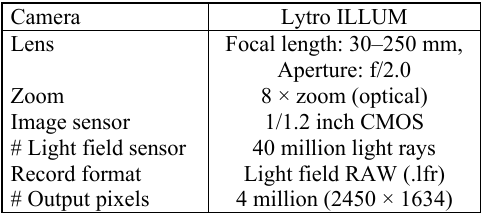
Table 1. Specification of the light field camera